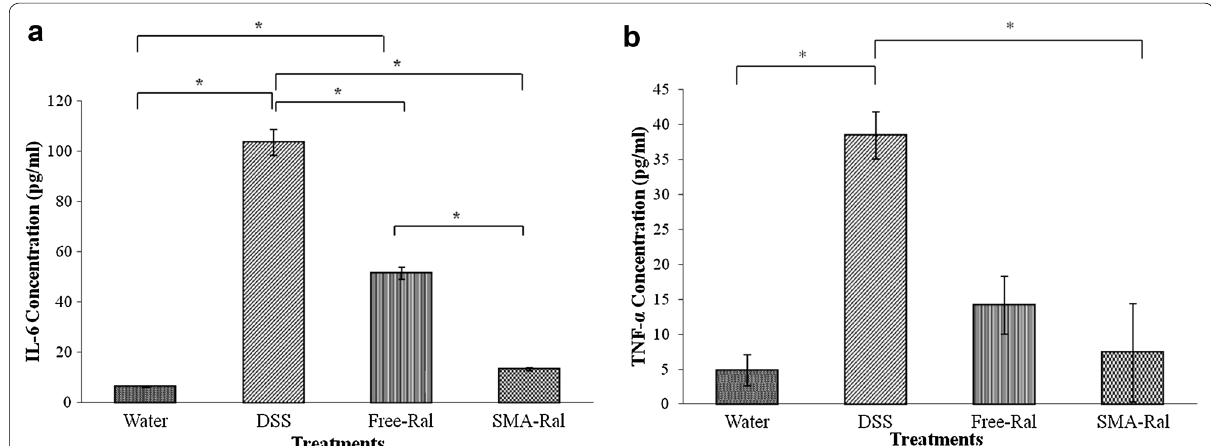
Fig. 6 a Effect of free and SMA Ral treatments compared to DSS or water treatment on mouse IL6 expression levels. b Effect of free and SMA Ral treatments compared to DSS or water treatment on mice TNF-α expression levels. All data are expressed as mean ** denotes p 0.001 as determined by t ≤